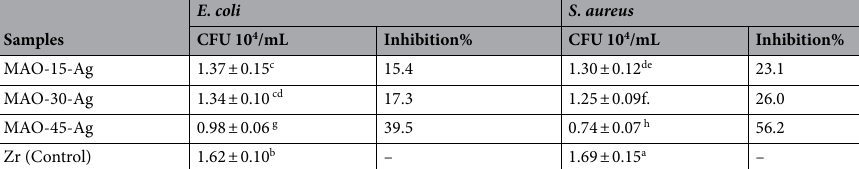
Table 3. Bacterial adhesion to the samples and percentage of adhesion inhibition. a–h Statistical significance between means was assessed using one-way analysis of variance followed by Duncan’s test as a post-analysis of variance test. Data are presented as mean and standard deviation (SD). The data shown with the same letters are statistically insignificant ( p > 0.05), while those indicated with different letters are statistically significant ( p < 0.05).